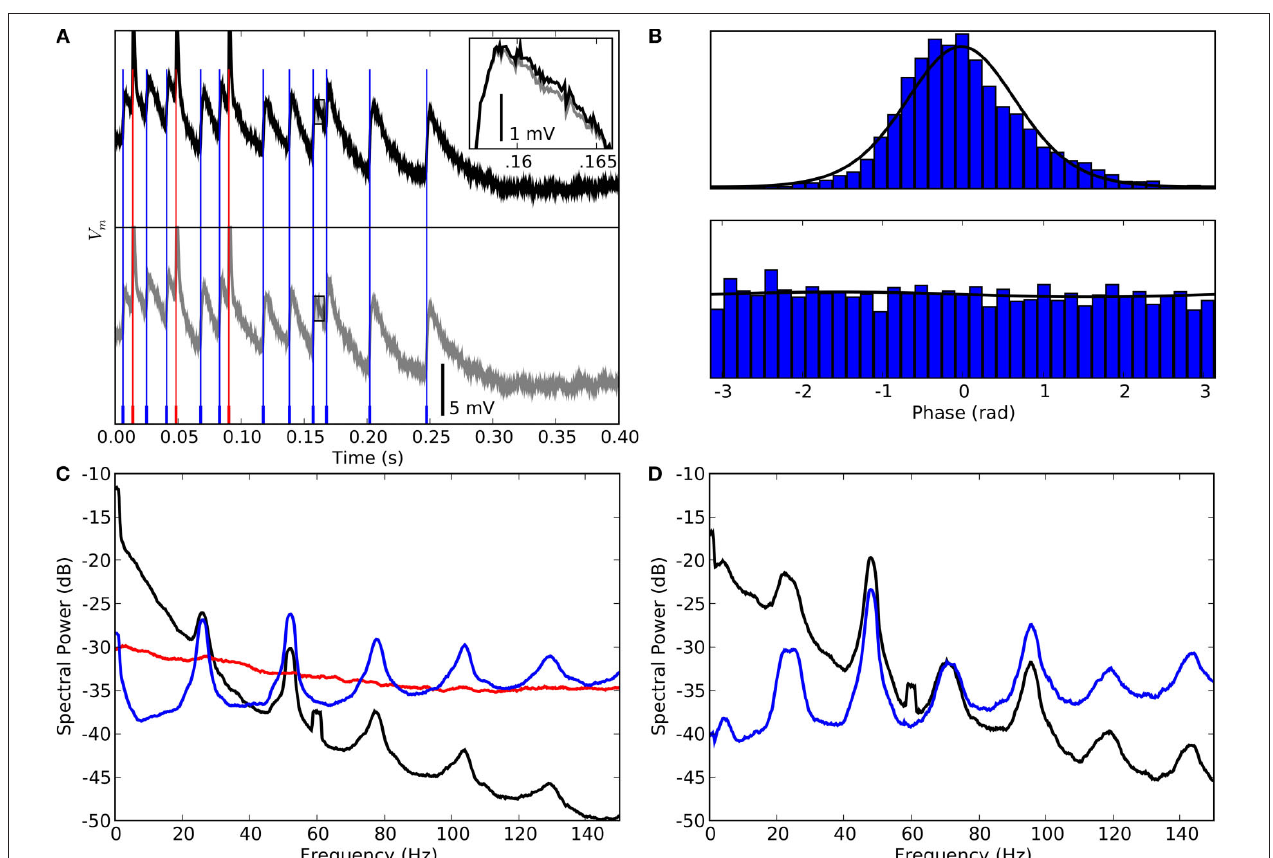
FIGURE 4 | Controls for potential artifacts introduced by power line or the stimulus. (A) Example of a recording contaminated with artifacts from the power line before (bottom panel, gray trace) and after (top panel, black trace) removal of line noise (60 ± 0.1 Hz). The shapes of the EPSPs in both traces are very similar; vertical lines mark timings of spikes (red) and EPSPs (blue). The inset shows a single EPSP at higher magnifi cation (marked by the rectangle in the main plot).